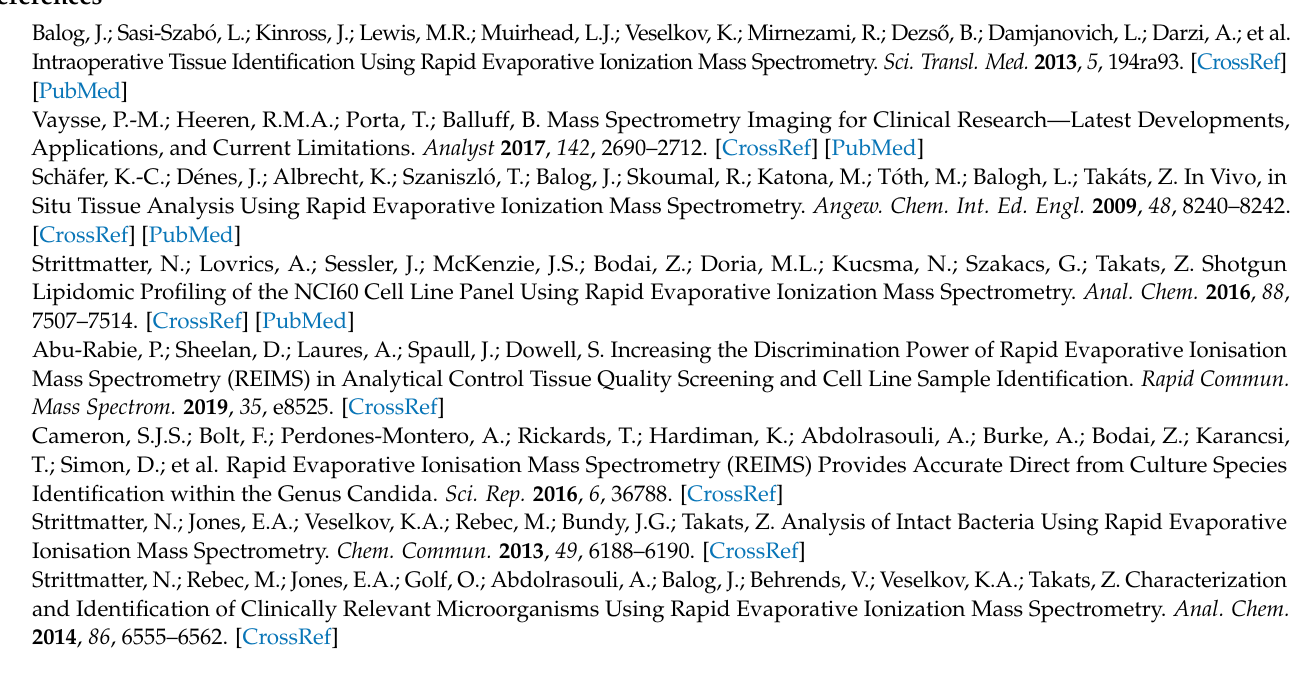
Figure S3: Analyst-dependent differences in REIMS spectra; Figure S4: Relative abundance of selected m/z bins in food-grade meats by meat type; Figure S5: Relative abundance of selected m/z bins in food-grade meats by center; Table S1: LSVC analysis of pork liver reference material and food-grade